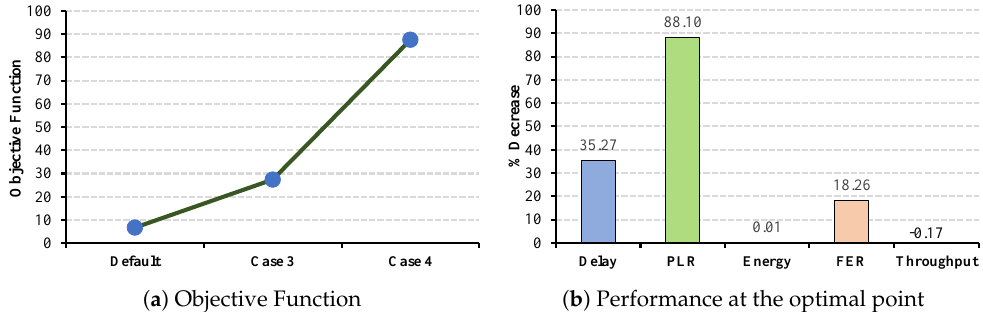
( b ) Performance at the optimal point Figure 14. ECG QoS metrics and energy consumption under CW changes for slave